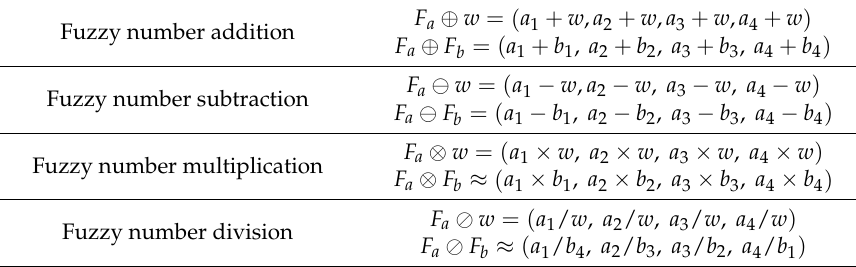
Table 1. Fuzzy arithmetic based on trapezoidal fuzzy number (TrFN). Fuzzy number